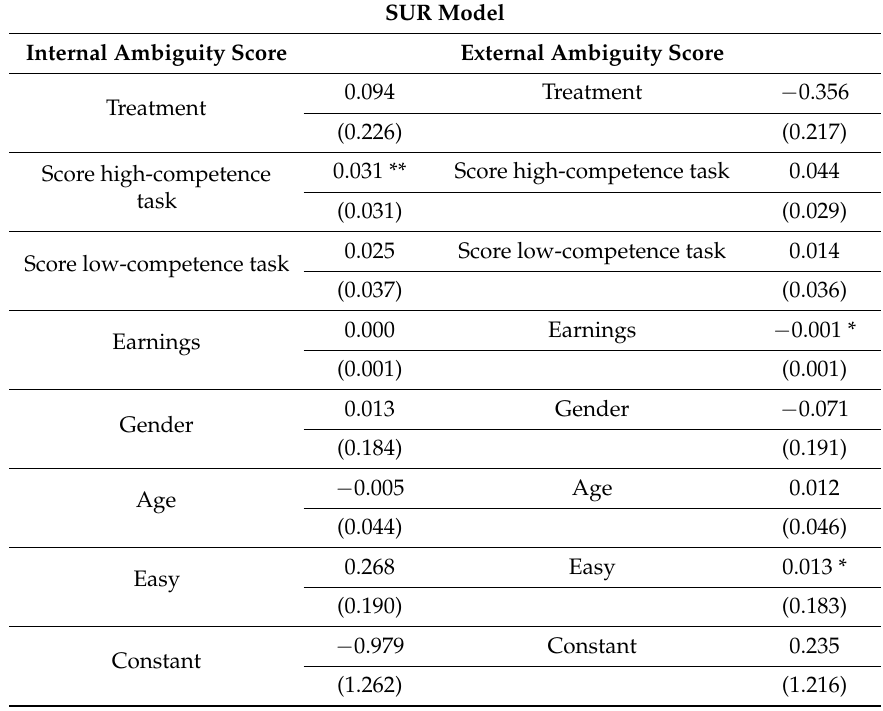
Table 8. The determinants of Internal and External Ambiguity